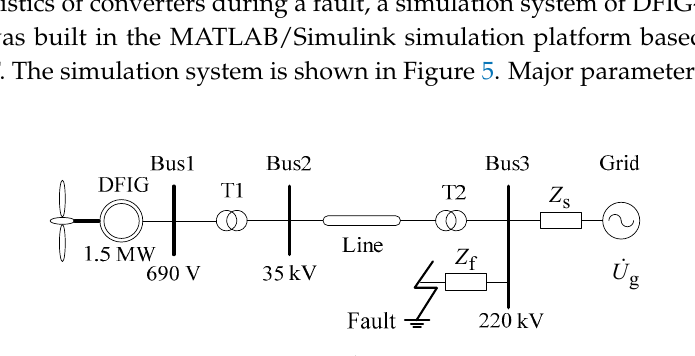
Figure 5. Simulation system. Table 2. Parameters of the DFIG-WT simulation model.